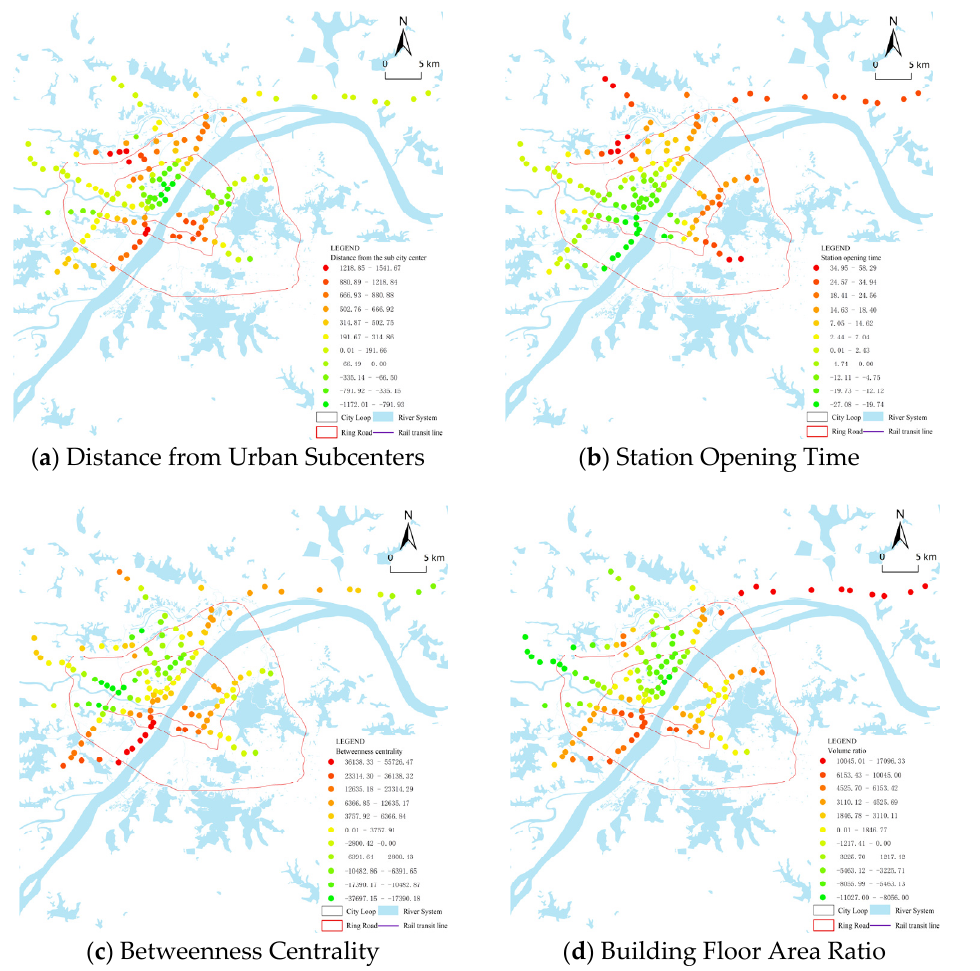
Figure 6. Spatial variation in the impact of different built environment elements on metro travel distance for the elderly.